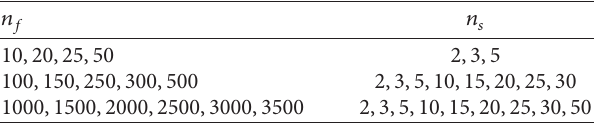
Table 6: Size files and storage supports pair